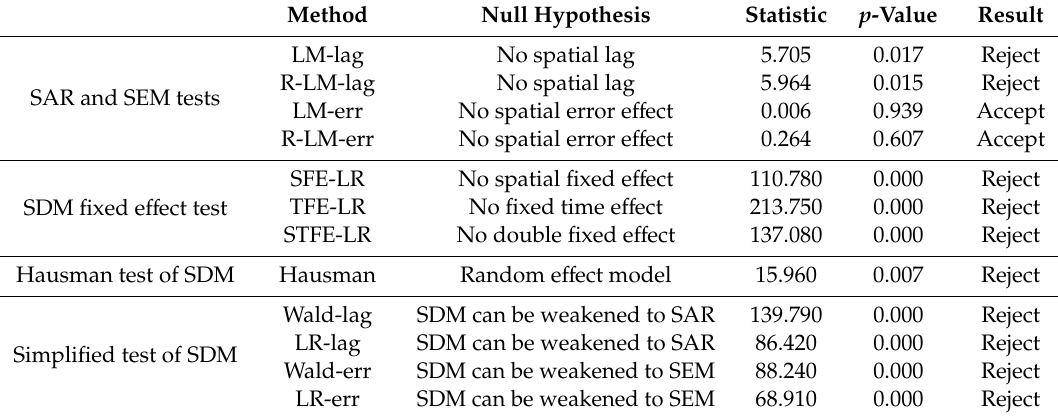
Table 8. Spatial panel data model test (GDP / IS) under the geospatial